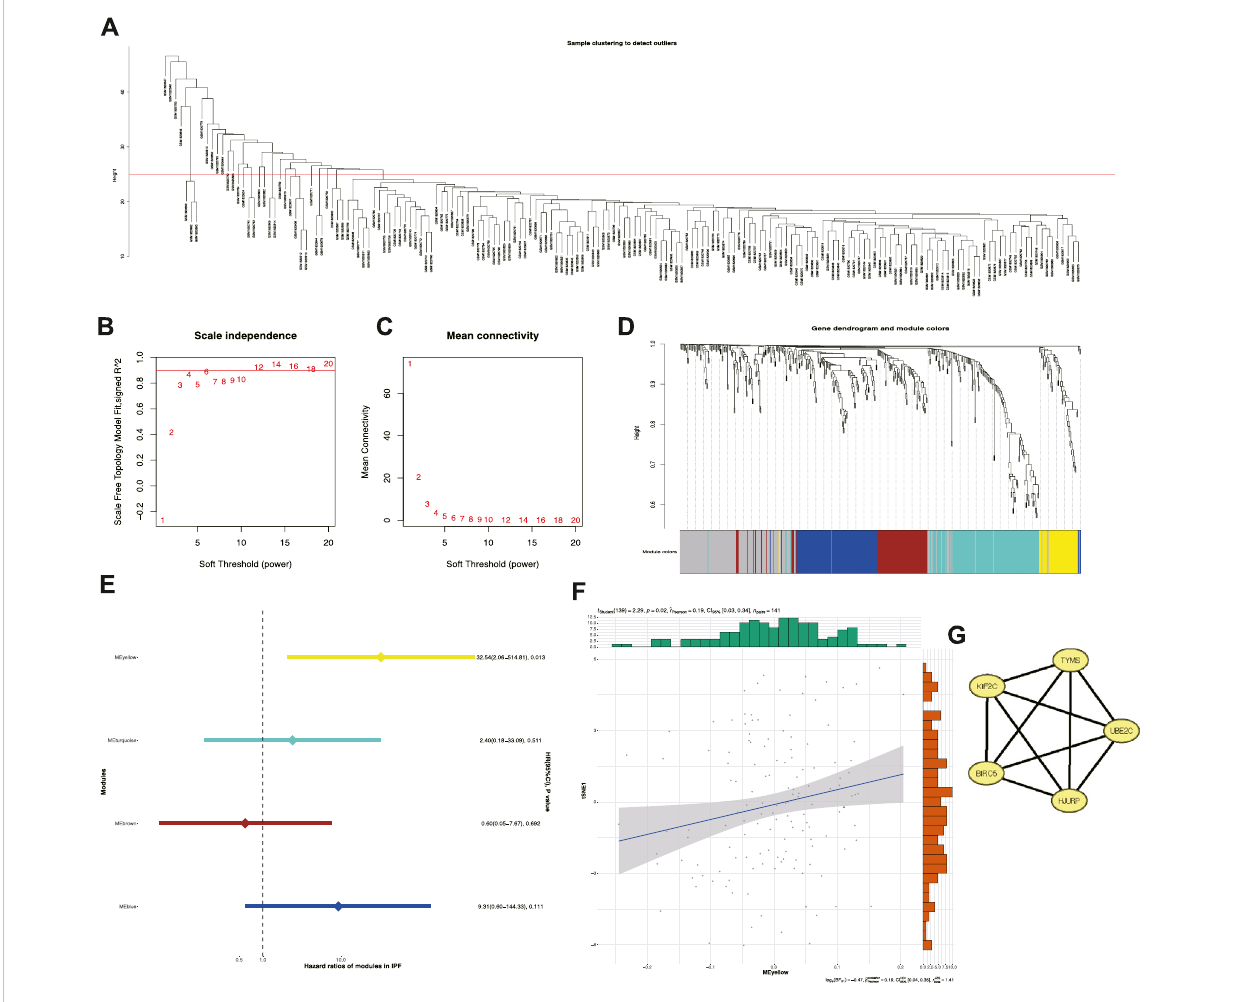
FIGURE 6 Identi fi cation of cellular senescence-related prognostic modules and hub genes. (A) Sample clustering. (B) Scale-free fi t index for various soft- thresholdingpowers. (C) Mean connectivity for various soft-thresholding powers. (D) Dendrogram ofcellularsenescence-relatedgenesclustered based on a one step method. (E) Forest maps of single factor survival analysis of modules of IPF. (F) Correlation between yellow module feature vector and second component of t-SNE. (G) Five hub genes identi fi ed in yellow